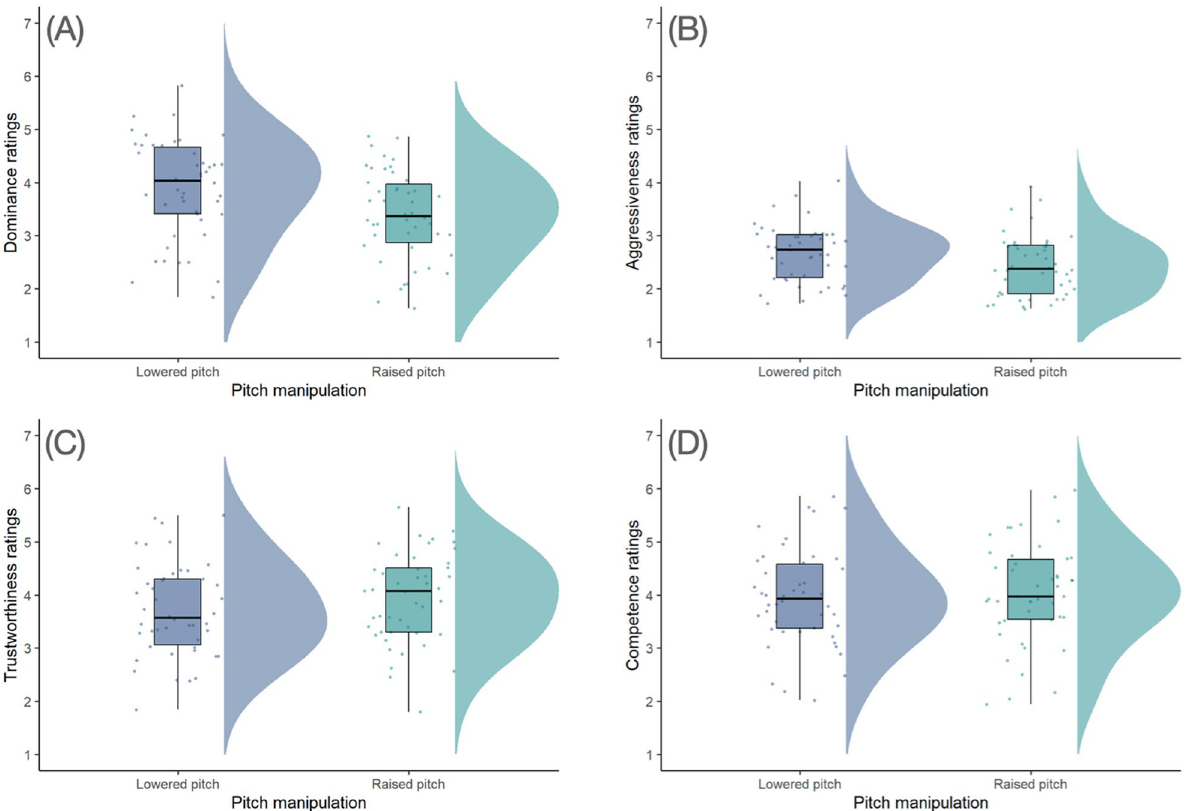
Figure 2. The effect of pitch manipulation on ( A ) dominance, ( B ) aggressiveness, ( C ) trustworthiness, and ( D ) competence ratings in Study 2. Significant effects of pitch were observed for dominance and aggressiveness ratings, but not trustworthiness or competence ratings. The points and distributions represent the average rating for each voice. The box plots show the median, first and third quartile, and the minimum and maximum dominance rating for low (purple) and high (green)